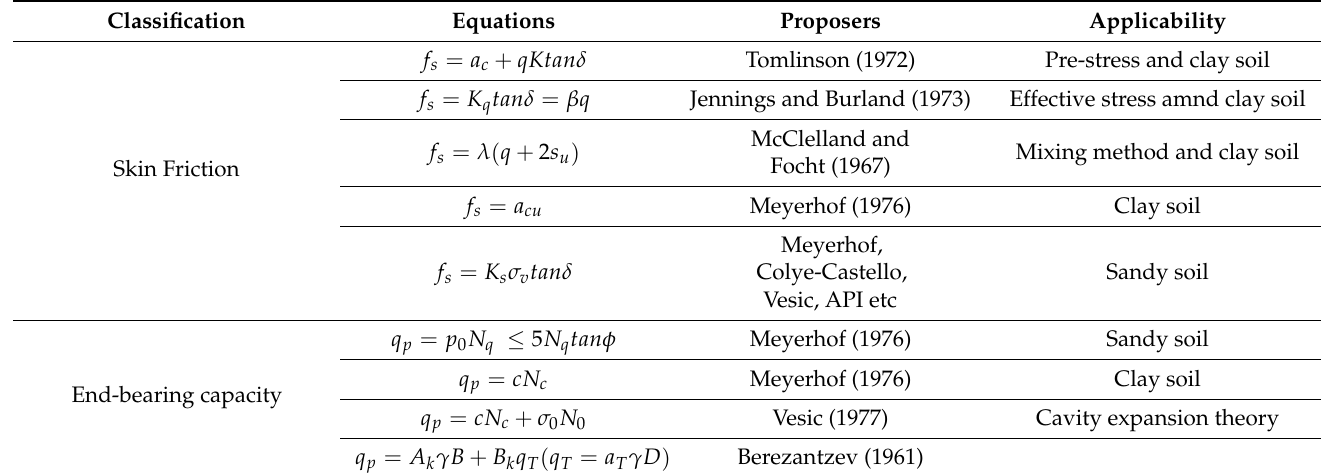
Table 1. Physical properties of reinforcements used for